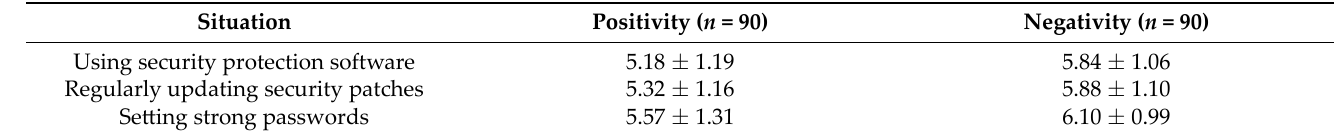
Table 4. Comparison of Means for Situation and Framework Properties (Mean ± SD ).